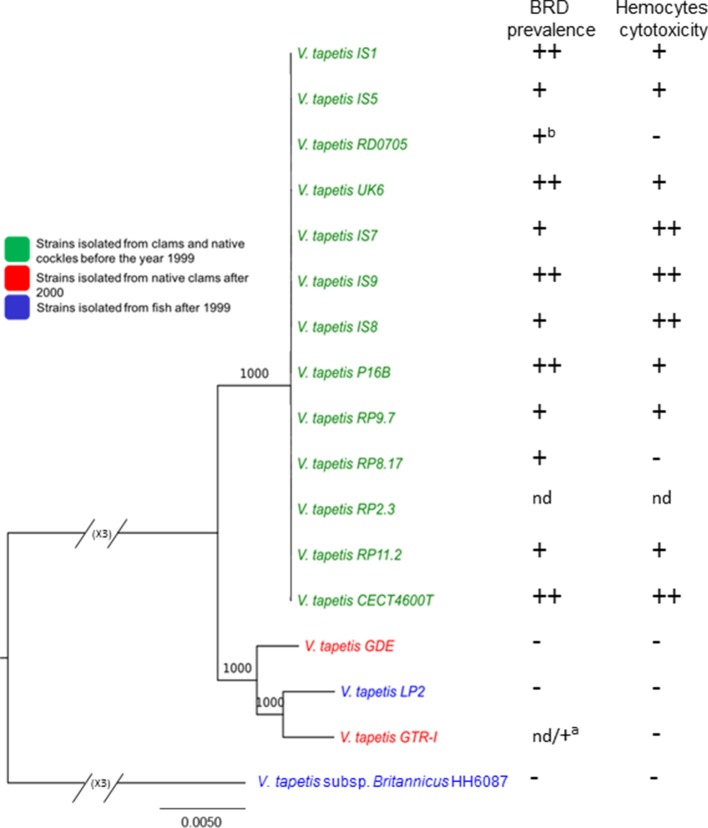
Maximum-likelihood tree of V. tapetis genomes based on single-copy genes of the V. tapetis core genome and pathogenicity assays. V. tapetis strains can be divided in three groups. The first group includes the virulent strains (green), while the two other groups comprise the less virulent strains (red and blue). Note that the branching pattern for the first group cannot be visible on this figure, due to the huge difference with the HH6087 strain; a specific tree for these strains is given as additional data (Figure S1). The numbers at the nodes indicate the levels of bootstrap support based on 1,000 replicates. Hosts and years of isolates are indicated in the legend. On the right of the figure, BRD prevalence in clams (in vivo) after pallial inoculation (average obtained from 1988 to 2007) and hemocyte cytotoxic assay (in vitro) performed in 2014 are given. nd: not determined, aPathogenicity of GTR-I strain after pallial cavity inoculation in Polititapes rhomboides. bObtained from both this study and Novoa et al. (1998). BRD prevalence; (−): average lesser than 20%, (+): 20%<average< 65%, (++): average greater or equal to 65%. Hemocyte cytotoxic assay; (−): ratio ≤1, (+): 1<ratio<1,5, (++): ratio>1,5.